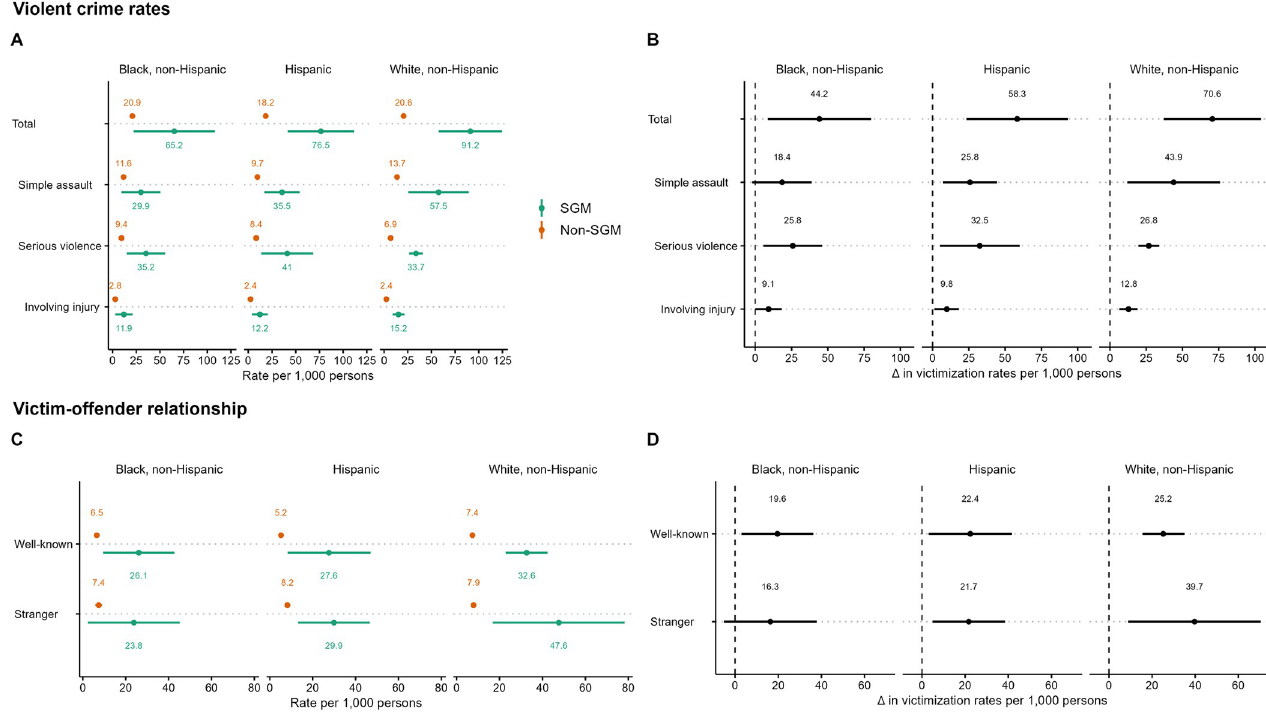
Fig 1. Violent victimization rates by race and ethnicity. (A) Types of violent victimization rates by SGM status and race and ethnic groups. (B) Differences in types of violent victimization rates between SGMs and non-SGMs by race and ethnic groups. (C) Victim-offender relationship victimization rates by SGM status and race and ethnic groups. (D) Differences in victim-offender victimization rates between SGMs and non-SGMs by race and ethnic groups. 90% confidence intervals represented by line segments.